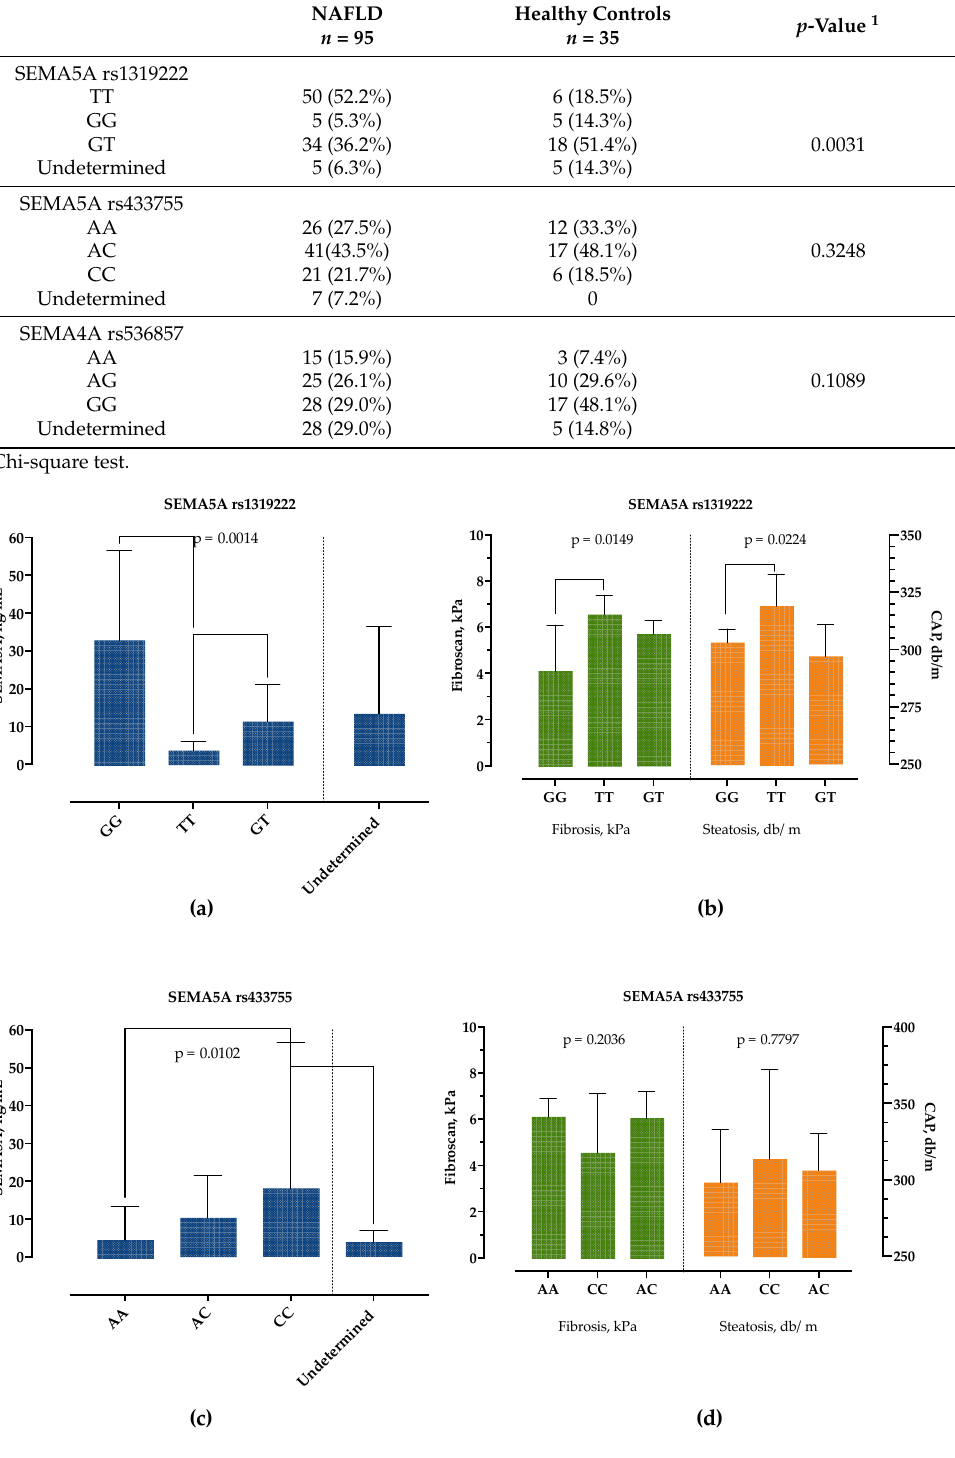
Figure 5. Association of SEMA5A rs1319222 and rs433755 genotype with SEMA5A serum concentrations ( a , c ) and liver stiffness (kPa) and controlled-attenuation parameter (db/m) measurements ( b , d ). Data are presented as median with interquartile range. The p -values are calculated by Kruskal–Wallis test, and significant differences calculated by Dunn’s multiple comparisons test.